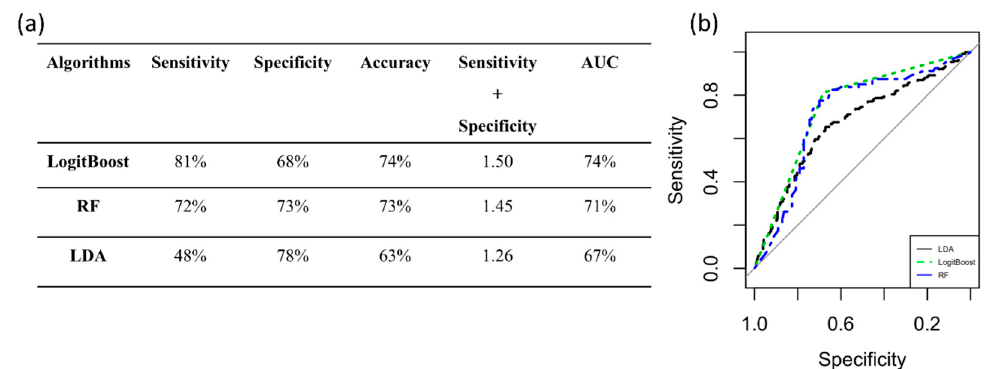
Figure 5. Performance measures to classify tumor grade. ( a ) Algorithm performance via PC3 to classify tumor grade. ( b ) ROC curves of the three classifiers. AUC: area under the curve; RF: random forest; LDA: linear discriminant analysis.